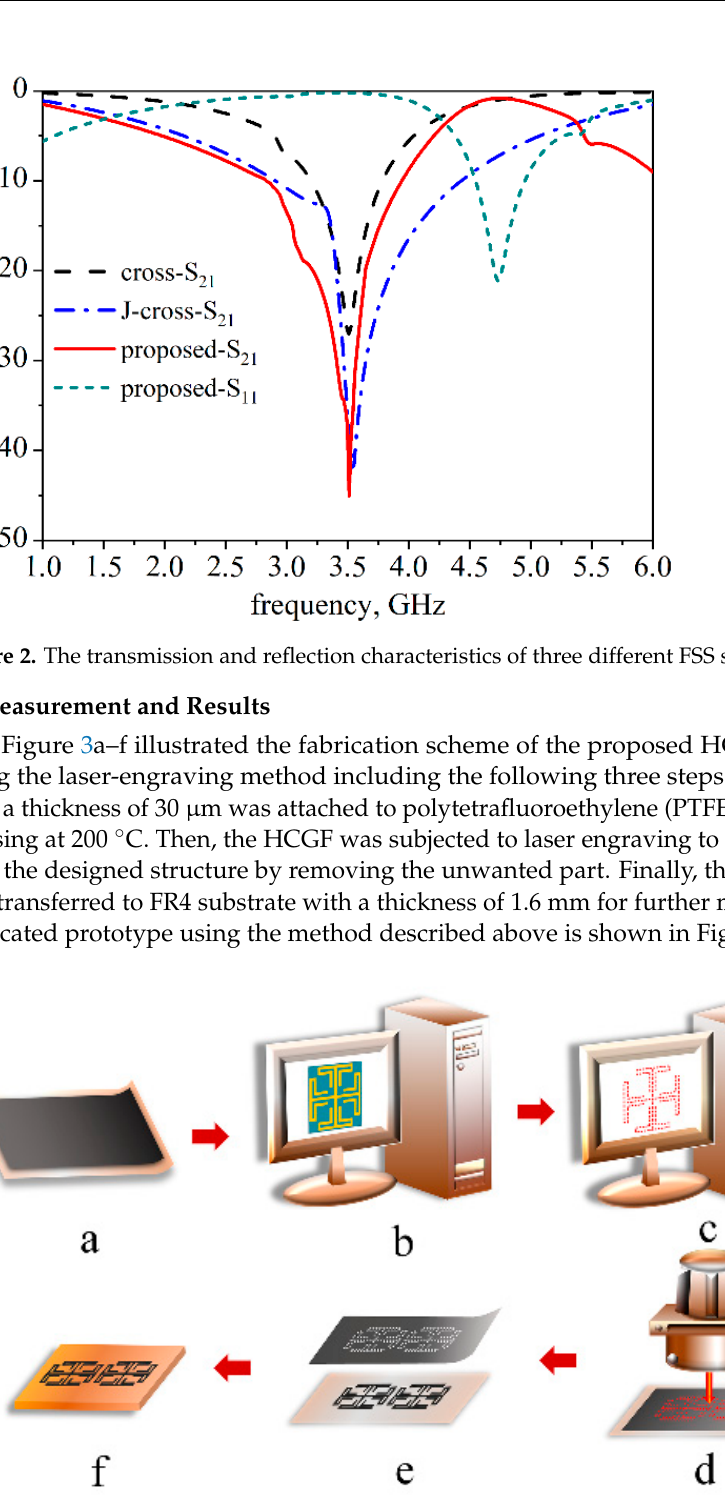
Figure 2. The transmission and reflection characteristics of three different FSS structures.